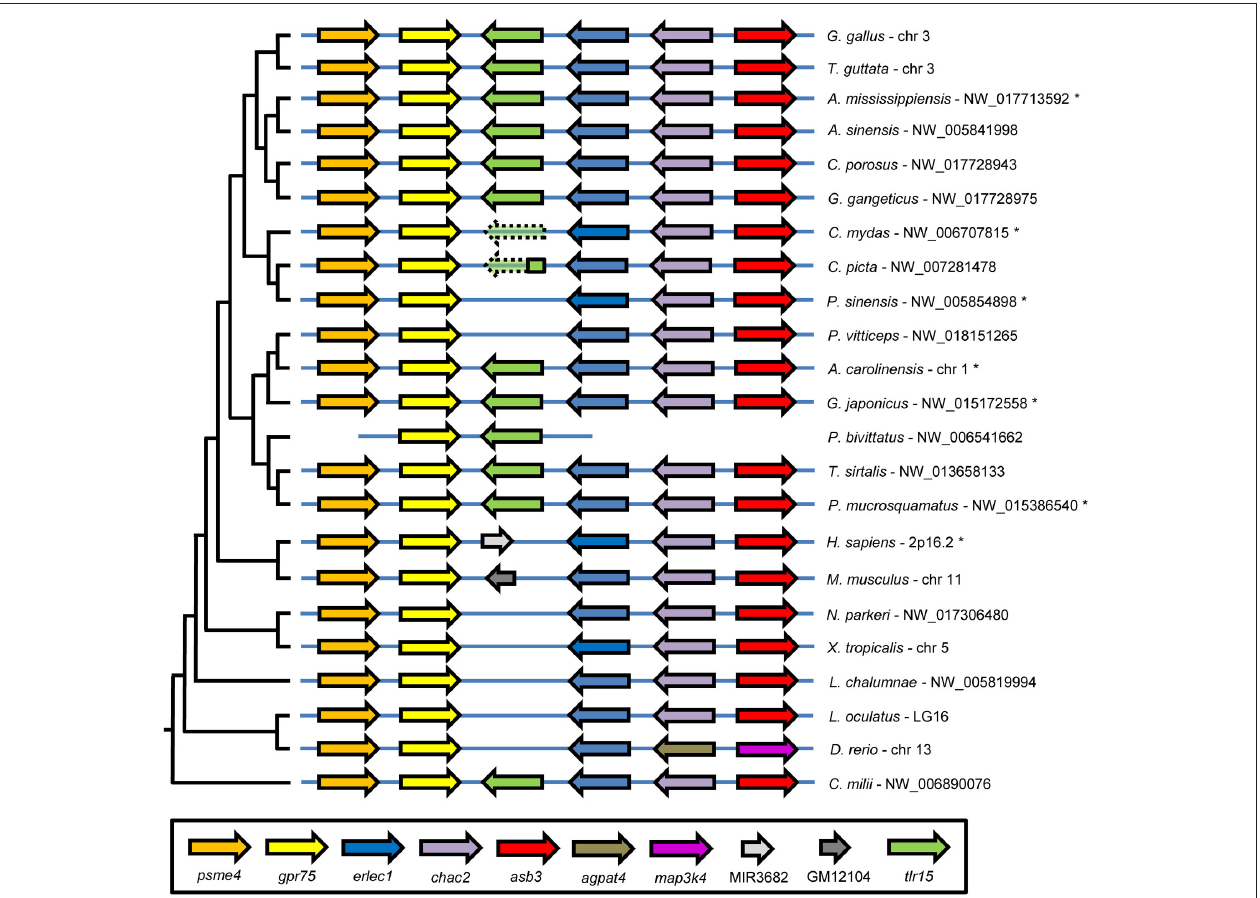
FIGURE 2 | TLR15 gene synteny comparison among vertebrates. The genomic region containing chicken ( G. gallus ) tlr15 compared to the same genomic region of the indicated species shows very high conservation of gene synteny. Genomic regions were collected from the NCBI Gene database and ordered according to the species phylogeny, shown on the left. Following the scientific name of each species is the NCBI Gene database identifier for this genomic region. Tlr15 is shown in green and putative tlr15 pseudogenes in the genomes of the C. mydas and C. picta turtles are shown in transparent color with a dashed line. Genes in this conserved genomic region are: proteasome activator complex subunit 4 (psme4), G-protein coupled receptor 75 (gpr75), endoplasmic reticulum lectin 1 (erlec1), ChaC cation transport regulator homolog 2 (chac2), ankyrin repeat and SOCS box containing 3 (asb3), 1-acylglycerol-3-phosphate O-acyltransferase 4 (agpat4),